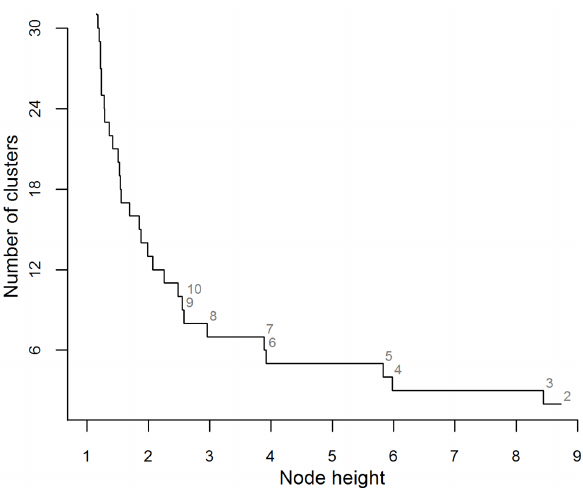
Figure 2. Fusion level values from the complete-linkage hierarchical cluster analysis on PDER events ( n =1268). Five groups have been retained for further non-hierarchical cluster analysis since k =5 is the first value of k where a small jump in node height was observed.